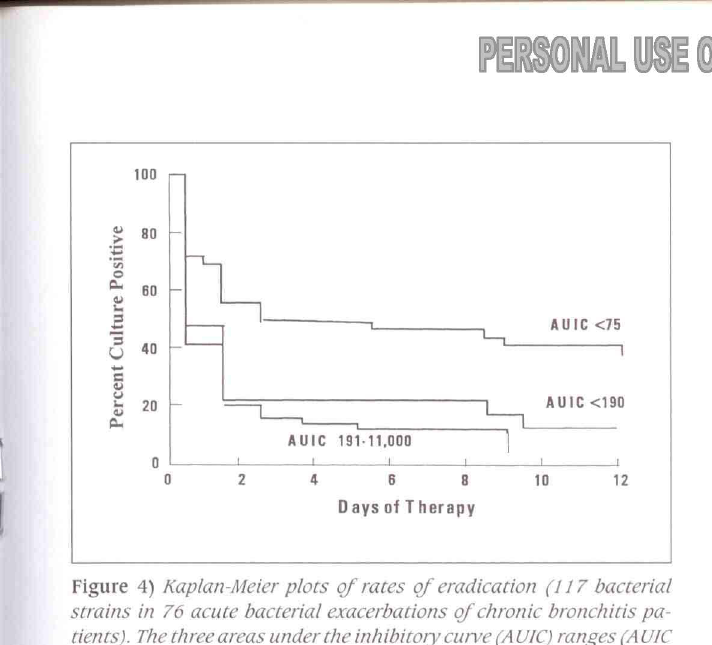
Figure 4) Kaplan-Meier plots qf rates qf eradication (117 bacterial strains in 76 acute bacterial exacerbations qf chronic bronchitis pa cients). The three areas under rhe inhibito1ycw11e (AU!C) ranges (AUIC less than 75, n=36 strains; AU!C between 75 and 190, n=23